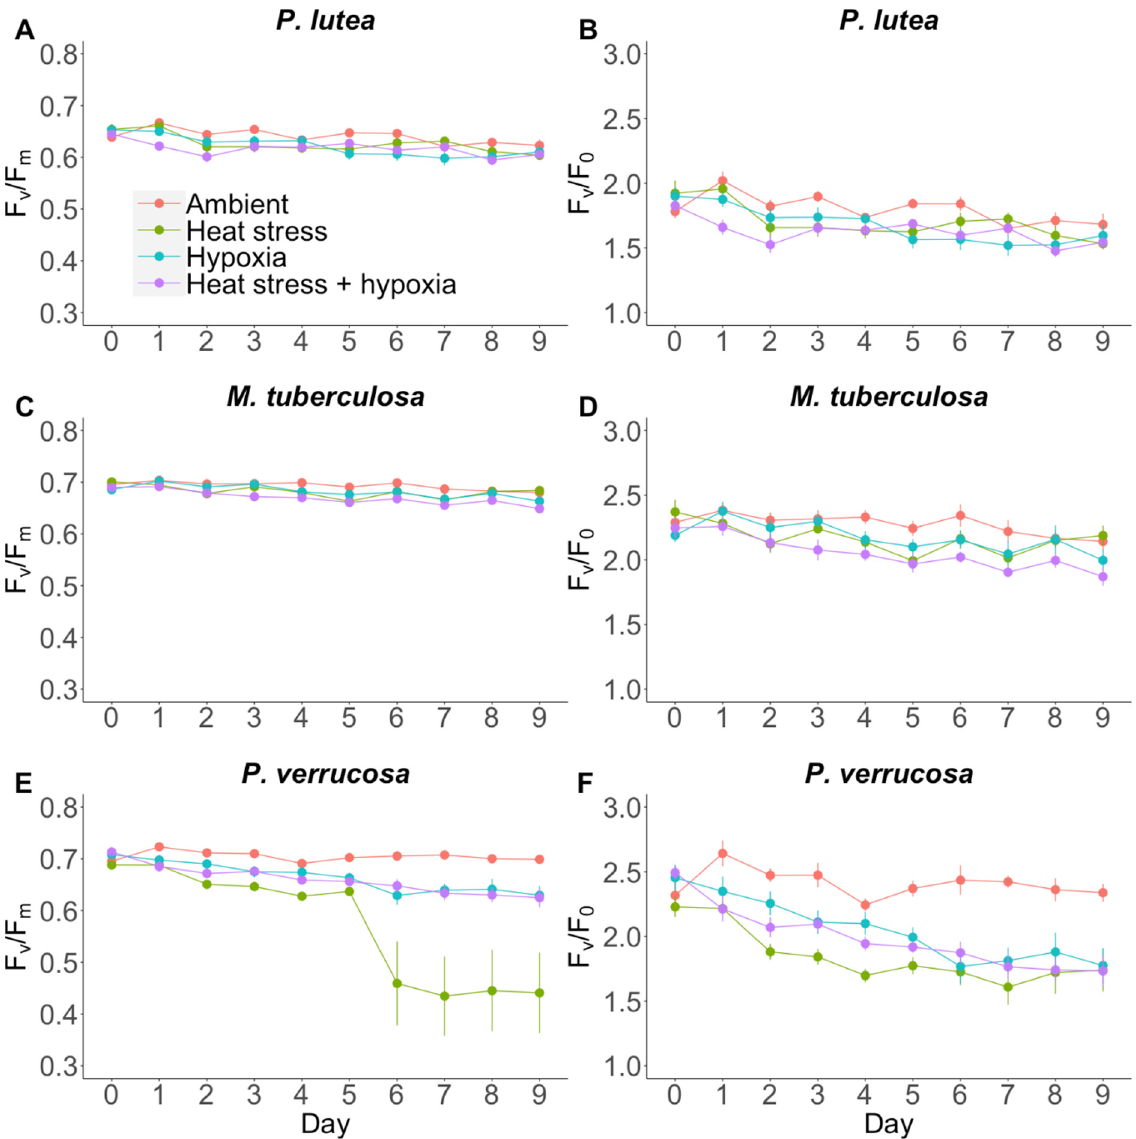
Figure 2. Maximum quantum yield of PSII (F v /F m ; left) and photochemical efficiency of PSII (F v /F 0 ; right) in P. lutea ( A , B ), M. tuberculosa ( C , D ), and P. verrucosa ( E , F ) measured before the light period. Data are shown as mean ± SE ( n = 4).